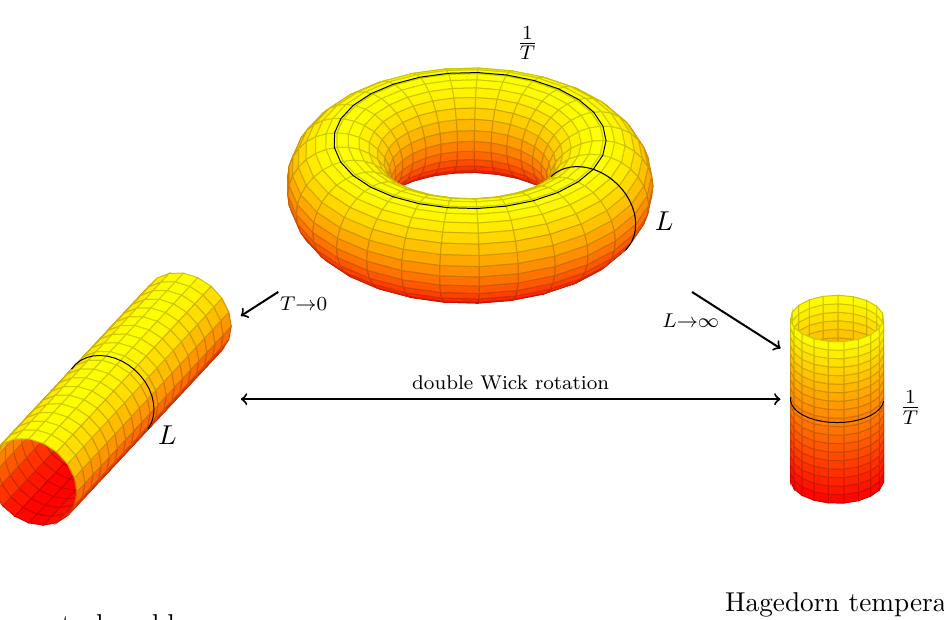
Figure 1. Calculating the spin-chain free energy at a finite temperature T for a chain of finite length L requires to consider the integrable model on a torus with circumferences 1 /T and L (top). In the spectral problem, the temperature is taken to be zero, resulting in a cylinder with circumference L (left). In the case of the Hagedorn temperature, we have to take the limit L → ∞ , resulting in a cylinder with circumference 1 /T (right). The former and the latter situation are related by a double Wick